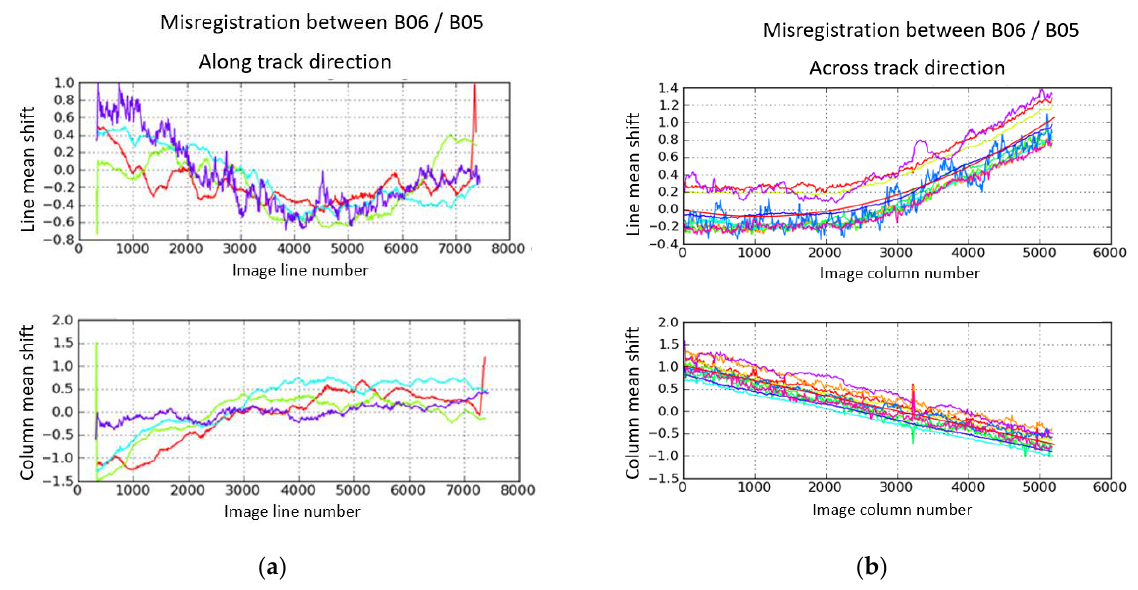
Figure 14. Example of misregistration profiles obtained with 4 spectral bands couples ( a ) along-track direction; ( b ) across-track direction. The couples of bands used were B05–B07 (red), B06–B07 (blue), B09–B10 (green) and B06–B05 (purple). Units are